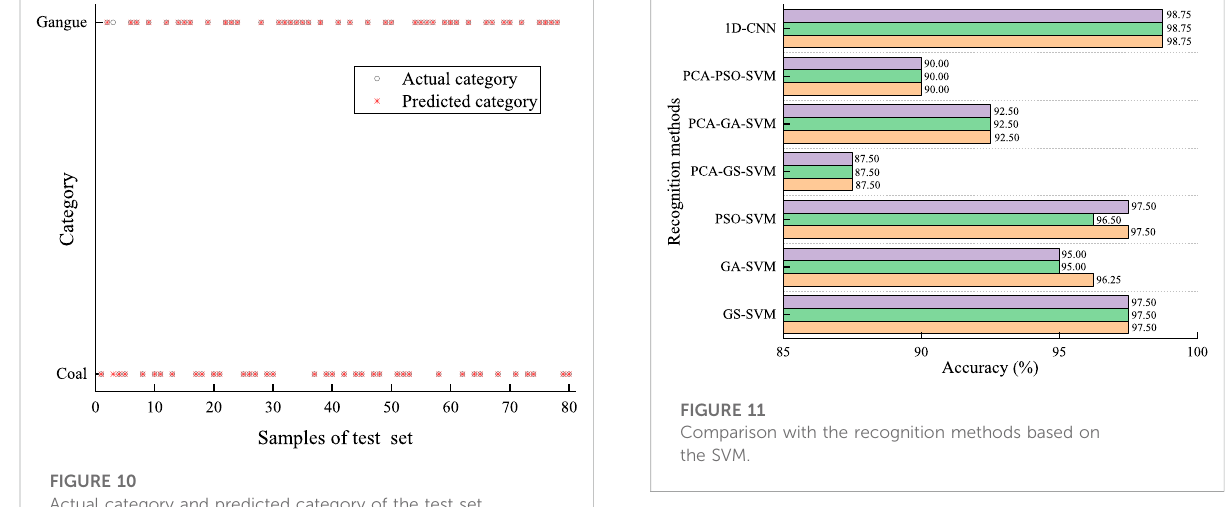
algorithm SVM (GA-SVM), and particle swarm optimization